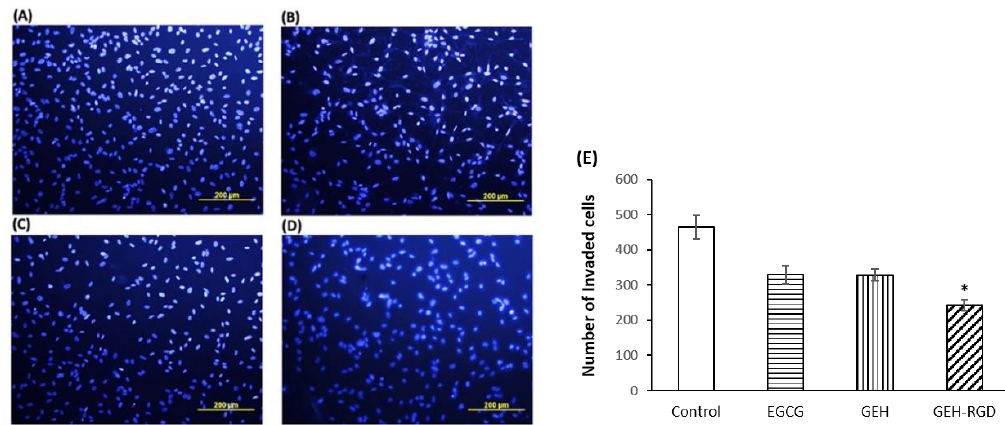
Figure A1. EGCG NPs inhibit endothelial cell migration. Representative images of HUVECs invaded across the membrane treated by ( A ) culture medium as control, ( B ) EGCG solution, ( C ) GEH NPs, and ( D ) GEH-RGD NPs at EGCG concentration of 20 µg/mL ( n = 3). ( E ) Numbers of invaded cells were calculated using ImageJ. * p < 0.05 compared with control, # p < 0.05 compared with GEH. Abbreviation: EGCG: epigallocatechin-3 gallate, HA: hyaluronic acid, RGD: arginine-glycine-aspartic acid, GE: Gelatin/EGCG self-assembling nanoparticles (NPs), GEH: GE NPs with HA surface coating, GEH-RGD: GE NPs with HA-RGD surface decoration, HUVECs: human umbilical vein endothelial cells.